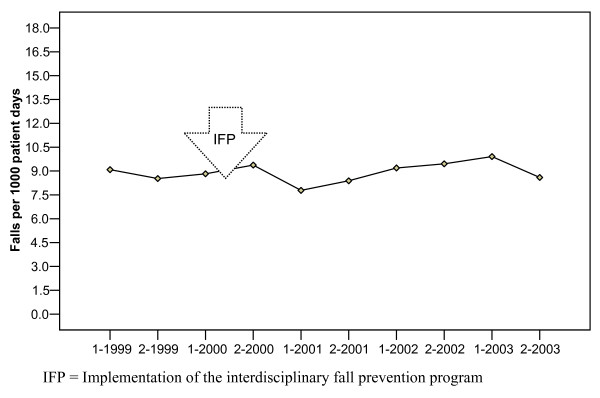
Hospital in-patient fall rates per half year from 1999 to 2003.